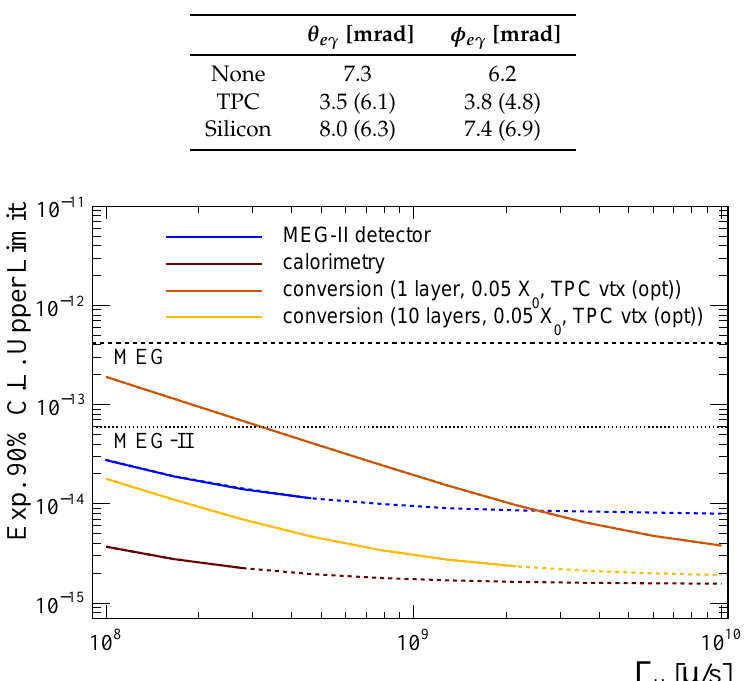
Table 4. Angular resolutions for different types of a vertex detector. A conservative estimate is given in parentheses.